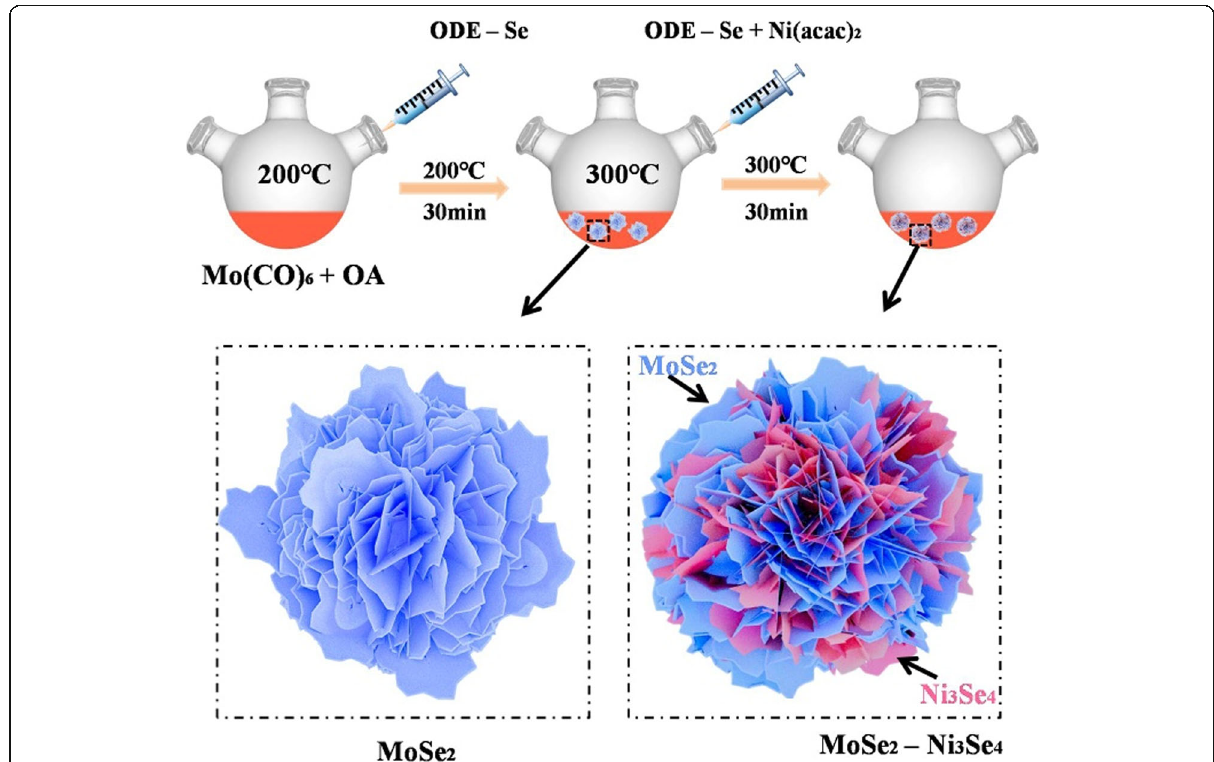
Fig. 1 Schematic diagram of the formation of MoSe 2 – Ni 3 Se 4 hybrid